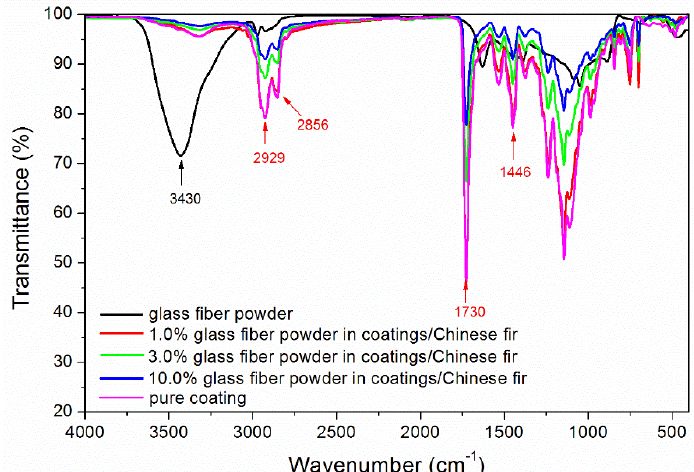
Figure 6. Infrared spectra of di ff erent concentrations of glass fiber powder in the waterborne coatings with thermochromic ink.